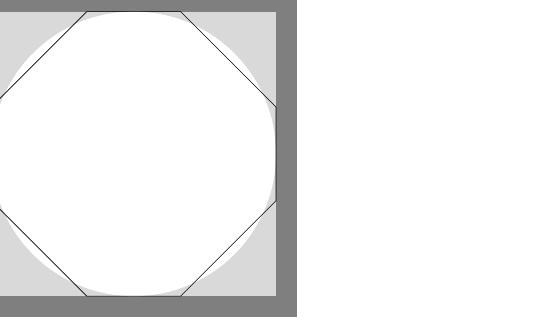
Figure 2. Washcoated channel cross-section showing the circular (light-gray) and octo-square (solid black line) approximations for the washcoat